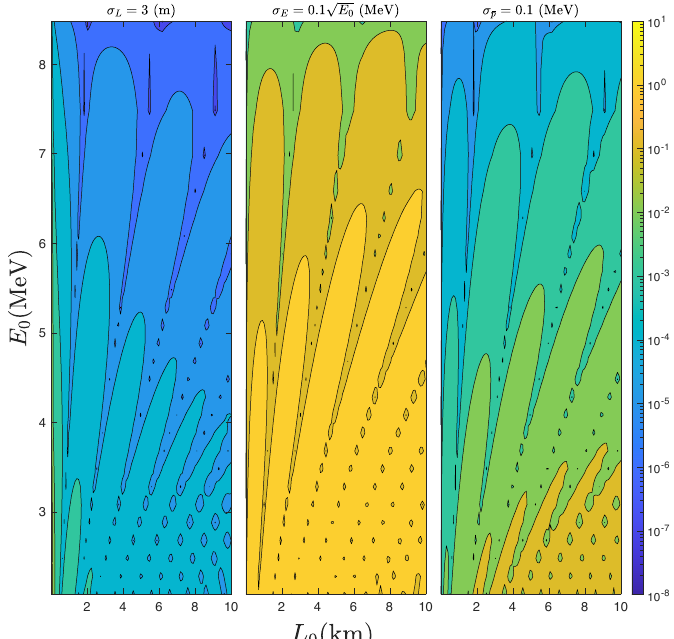
Figure 13 . The contour plot of the flux difference, | Φ( σ n 6 = 0) − Φ( σ n = 0) | for reactor neutrinos, where the energy spectrum and the decrease with traveling distance for reactor neutrinos are taken into account. The formalism is given in eq.